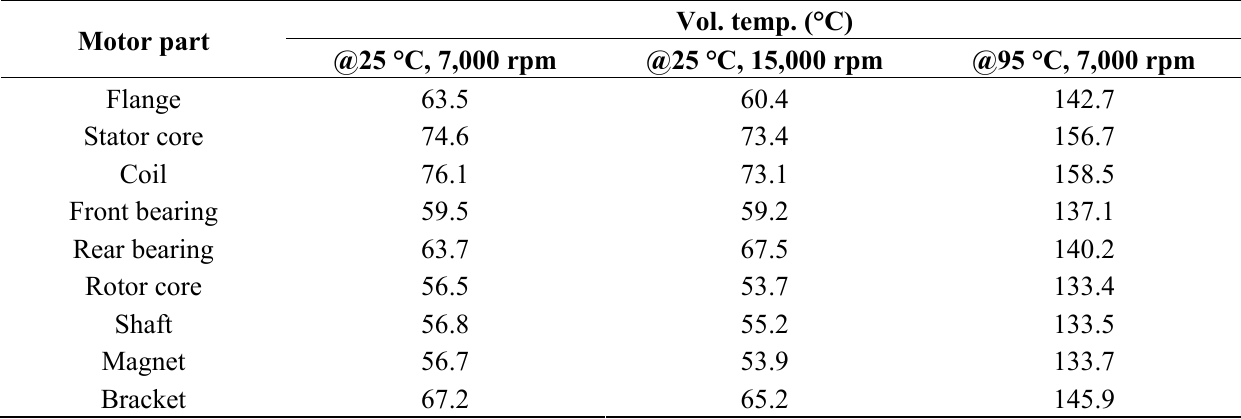
Table 4. Temperature values of each motor part at different motor speeds and ambient temperatures.